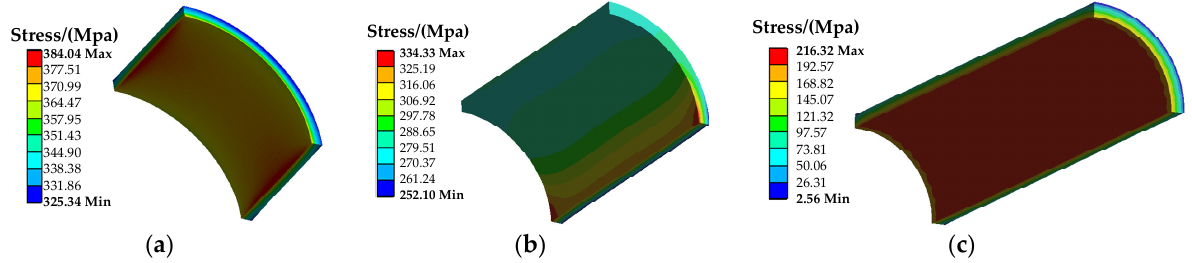
Figure 21. Sleeve Von − Mises stress distribution under the three cases at rated speed in a hot state: ( a ) Case 1; ( b ) Case 2; ( c ) Case 3.